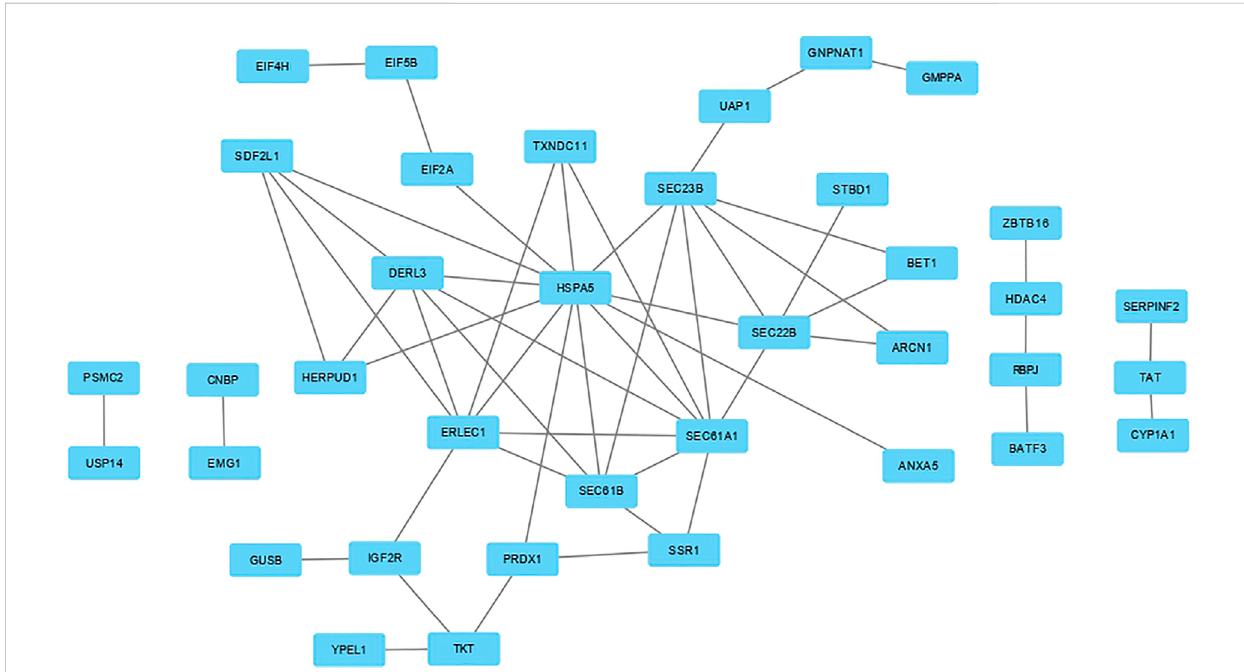
FIGURE 2 Protein-protein interaction (PPI) network analysis based on meta-genes. By de fi nition, the meta-genes were those gene that were signi fi cantly differentially expressed between the chickens under acute heat stress and their corresponding control group as well as those that were consistently expressed across the four datasets (with the same direction of expression) and were signi fi cant in the meta-analysis. The PPI network was constructed using the STRING